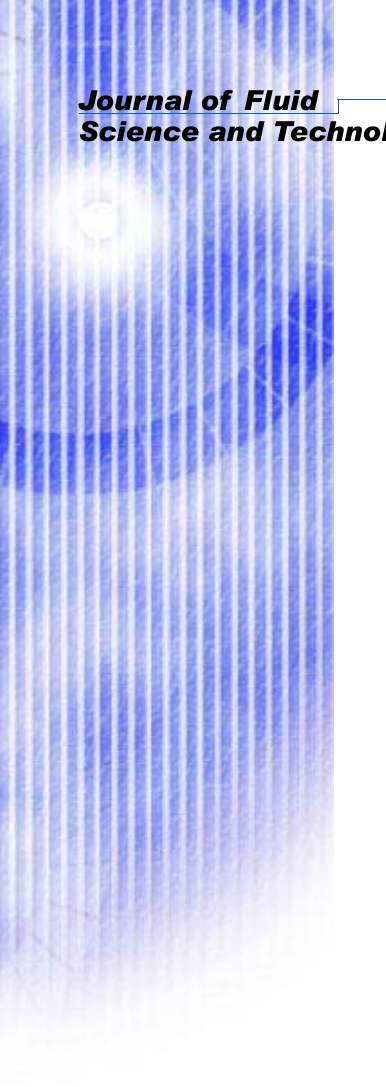
Fig. 16 Results of optimization for simple shaped object with different ratio of C